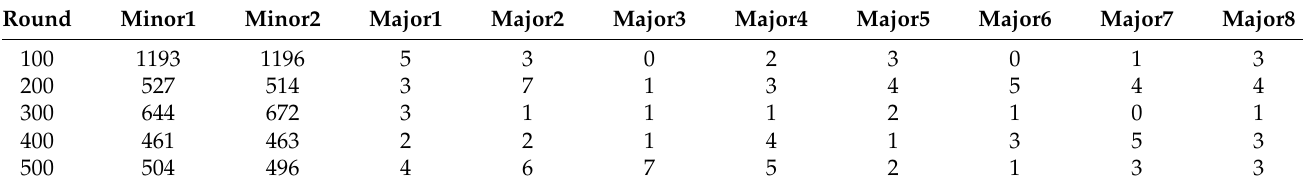
Table 8. FedWAvg forgettable example counts in each client when non-IID